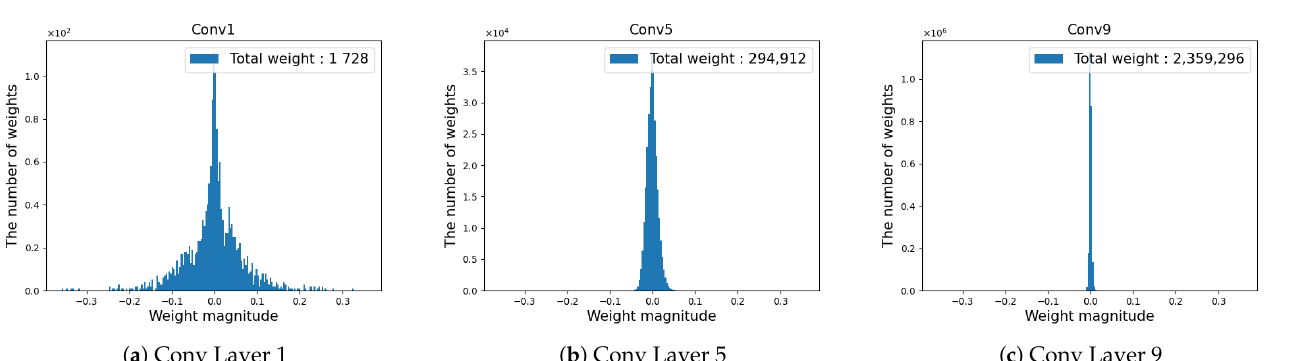
Figure 1. Weight histograms of some layers in a VGG-16 network. It shows that each layer has different weight distribution: ( a ) has the maximum weight magnitude around 0.4; ( b ) has the maximum magnitude about 0.05; and ( c ) has the maximum magnitude about